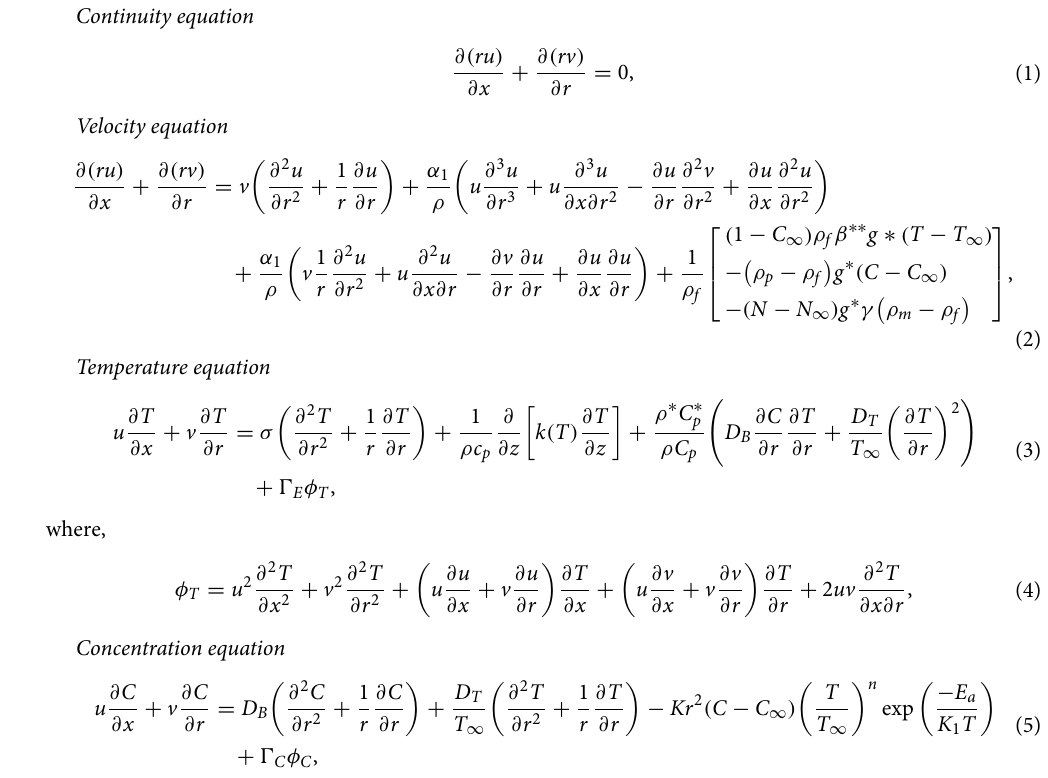
Figure 1. Geometry of problem